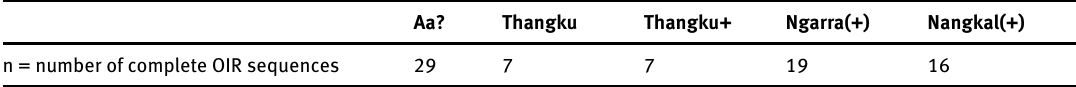
Table 5: Total raw counts for complete OIR sequences, per format.